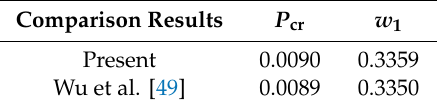
Table 2. Comparison of buckling and free vibration results for an intact clamped-clamped (C-C) FG-X-GPLRC